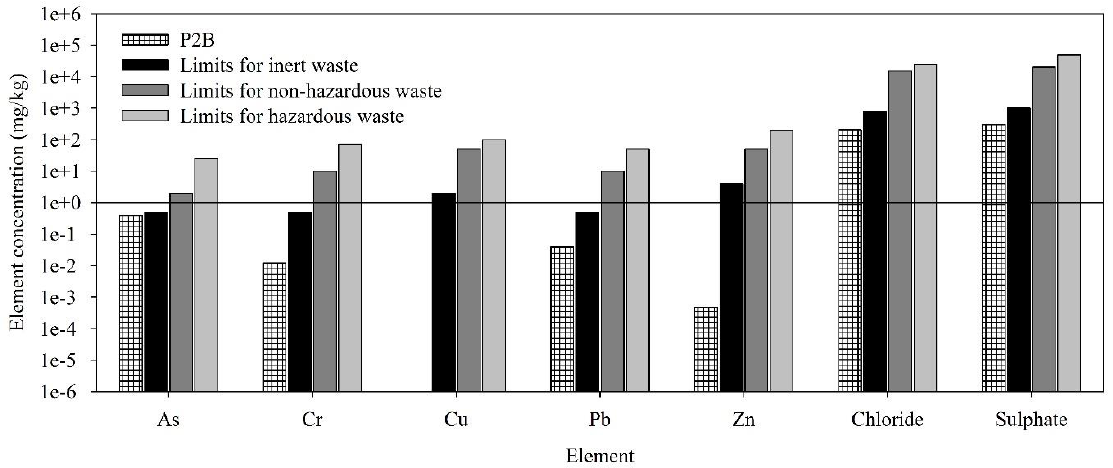
Figure 13. Concentration evolution in the solution where the paste P2B was submerged ( LTT2 ), compared with the waste acceptance limits (2003/33/EC) for non-hazardous waste.